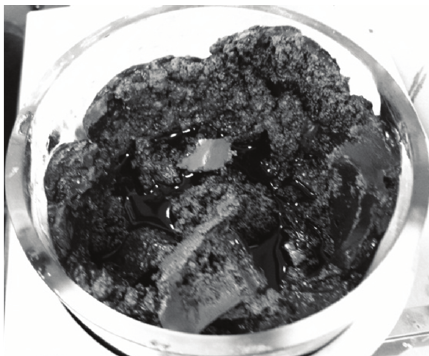
Figure 4: Limestone-oil suspension upon addition of 53 mL of water.